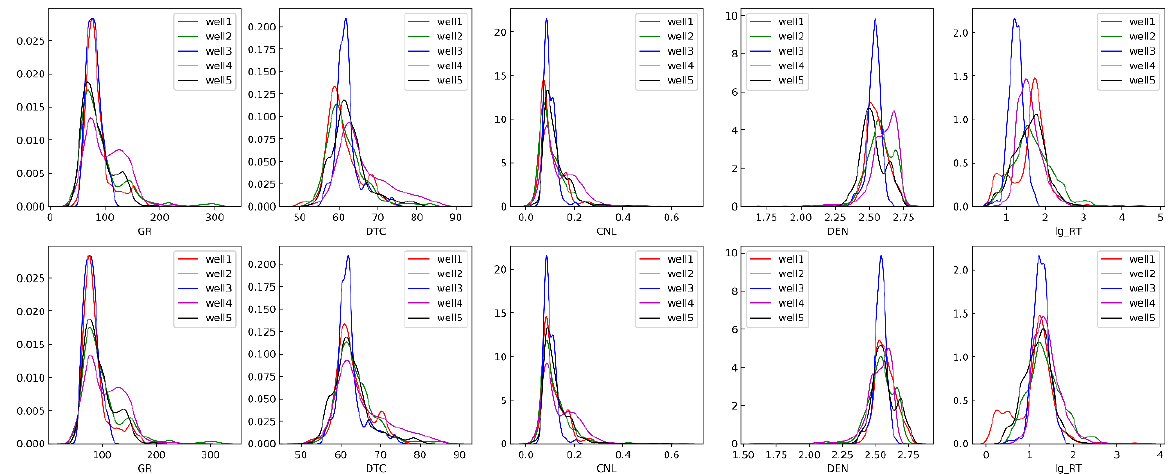
Figure 9. Comparison of statistical histogram pre- and post-multi-well standardization of input feature curves. The upper figure is a histogram of preprocessing, and the lower figure is a histogram of post-processing.